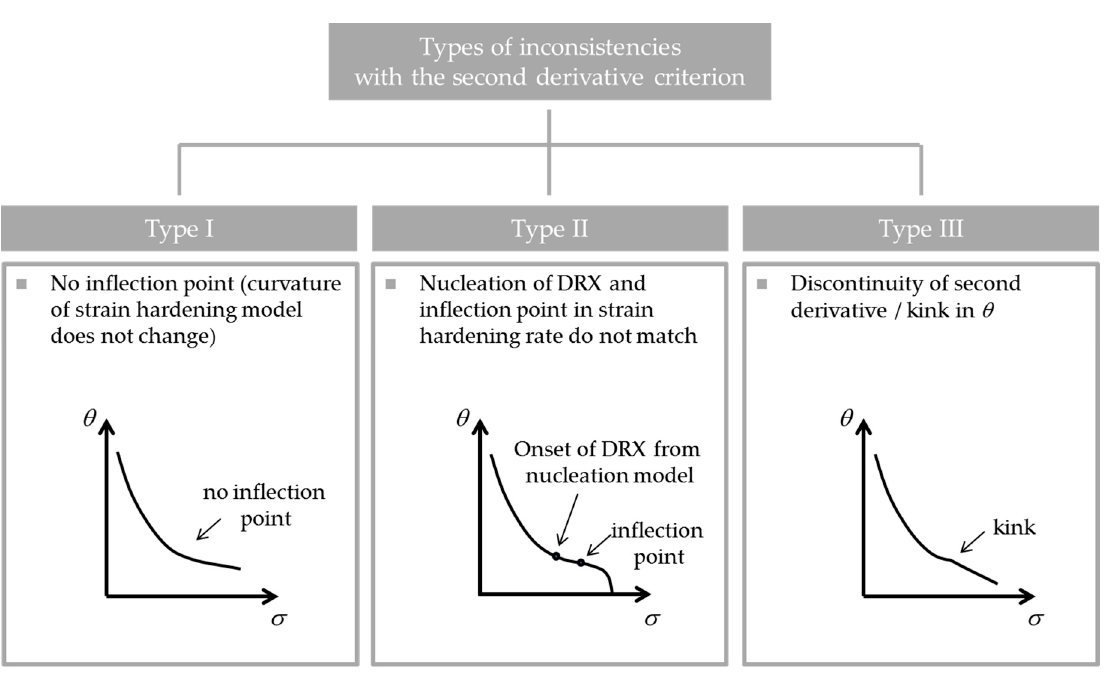
Figure 1. Schematic representation of three types of inconsistencies with the second derivative criterion (SDC) [25].